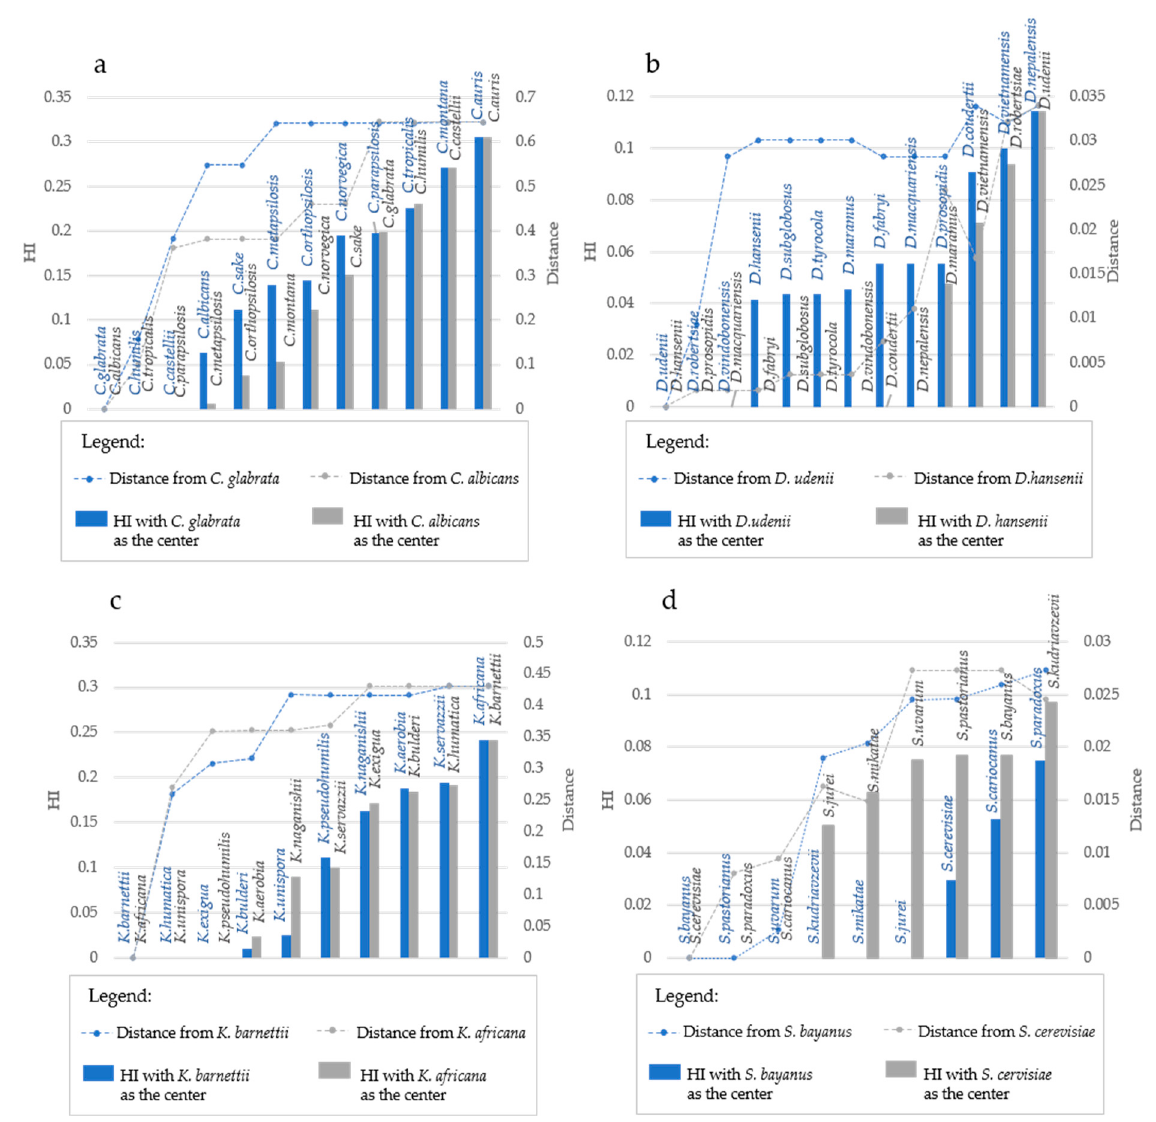
Figure 4. Homoplasy Index and Distance considering different starting strains. The plots report the variation in Homoplasy index and distance of ITS sequences, when two different species are considered the center of the distribution. Each plot reported in the primary Y-Axis (on the left) the value of HI, while the secondary Y-Axis (on the right) reported the value of distance from the center of the distribution. In the X-Axis species are reported. Species are displayed in increasing distance order from the center, represented by the two leftmost species of each graph. In ( a ), the gray bars represent homoplasy index and the gray line shows the trend of distance when C. albicans is considered the center, while blue bars and line represent respectively HI and distance when C. glabrata is the center of the distribution. In ( b ), gray bars represent homoplasy index and the gray line shows the trend of distance when D. hansenii is considered the center, while blue bars and line represent respectively HI and distance when D. udenii is the center of the distribution. In ( c ), gray bars represent homoplasy index and gray line shows the trend of distance when K. africana is considered the center, while blue bars and line represent respectively HI and distance when K. barnettii is the center of the distribution. In ( d ), gray bars represent homoplasy index and gray line shows the trend of distance when S. cerevisiae is considered the center, while blue bars and line represent respectively HI and distance when S. bayanus is the center of the distribution. The figure displays a difference in HI increase depending on the genetic distance. Genera composed of highly divergent species, such as Candida ( a ) and Kazachstania ( c ), did not show trend variation with different starting taxa.